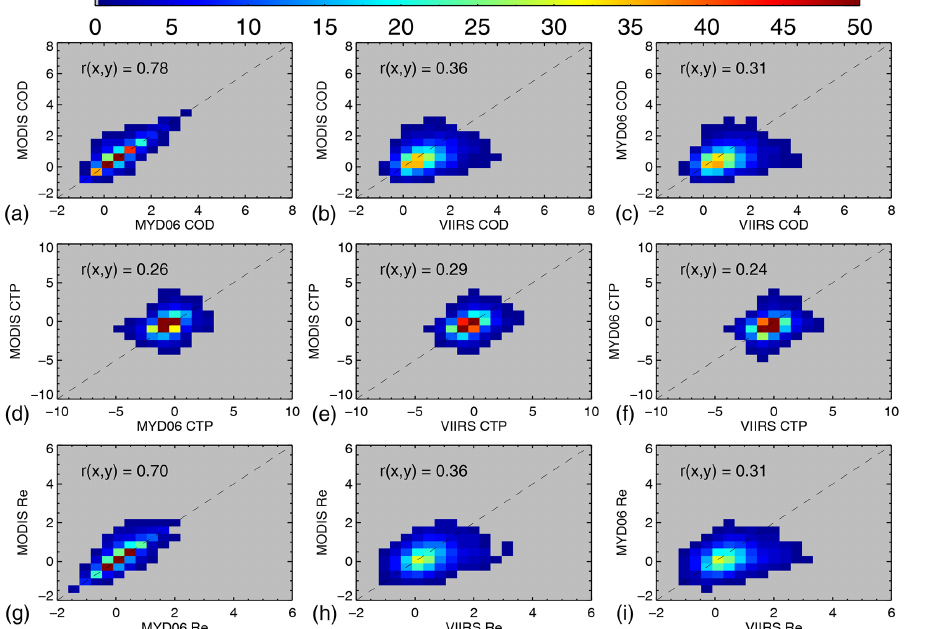
Figure 9. Similar to Figs. 8 and 7, except cloud property skewness over sounder FOV is used in the comparison. Results are shown on a linear scale. Linear correlation coefficients between the variables on the x and y axes are given in each